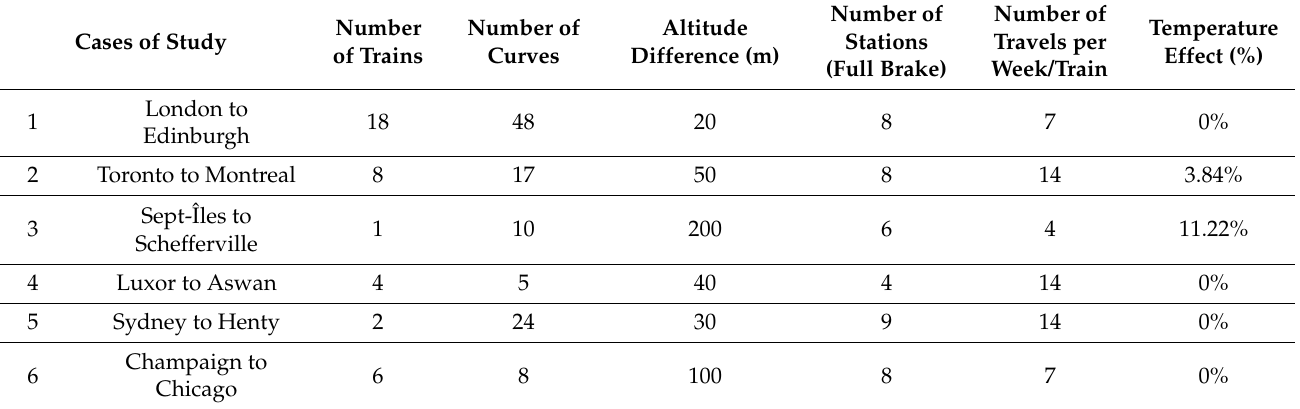
Table 4. Studied cases and their characteristics